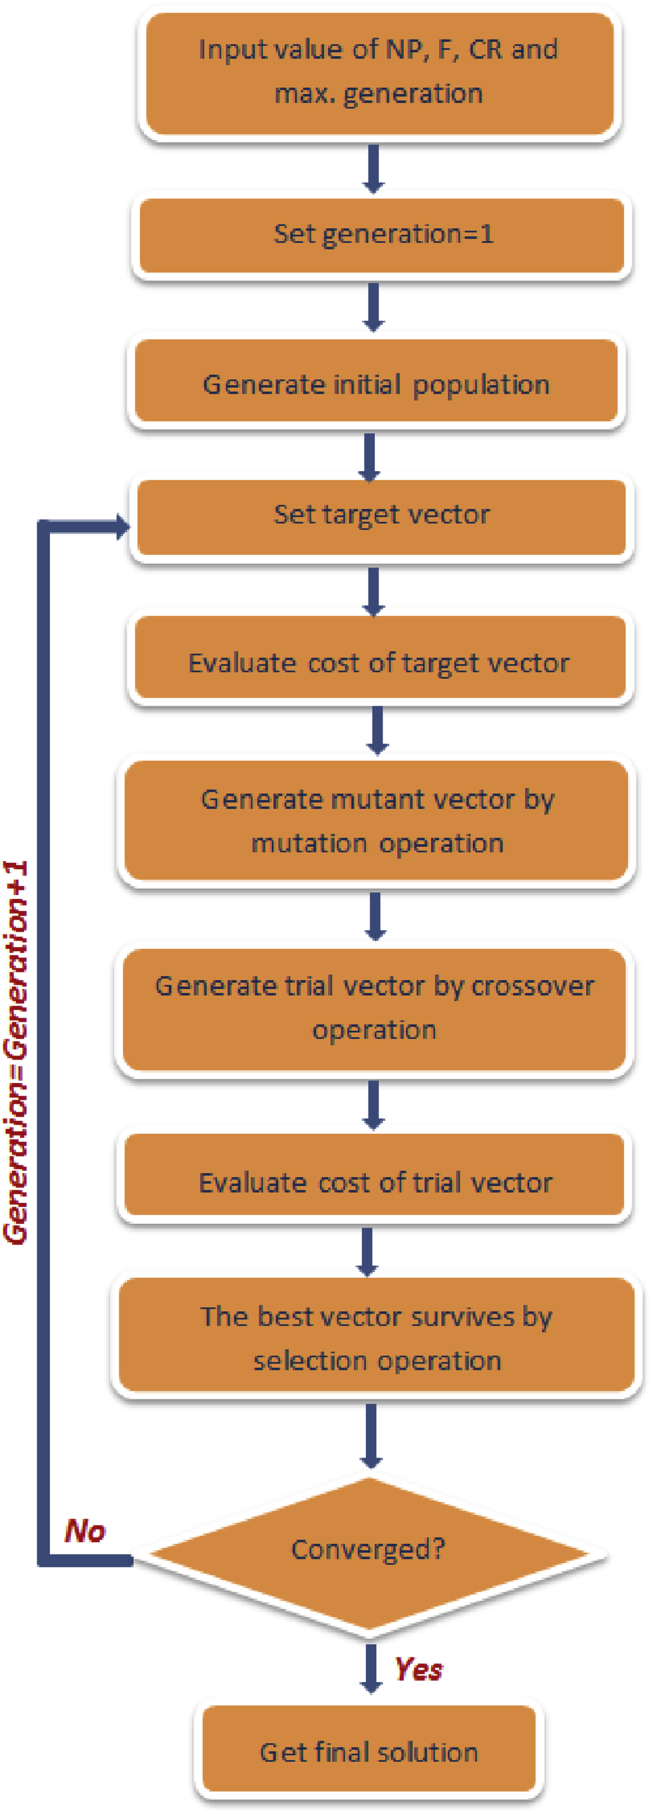
Steps for implementing the DE algorithm [Adapted from Zheng et al. (2012)].